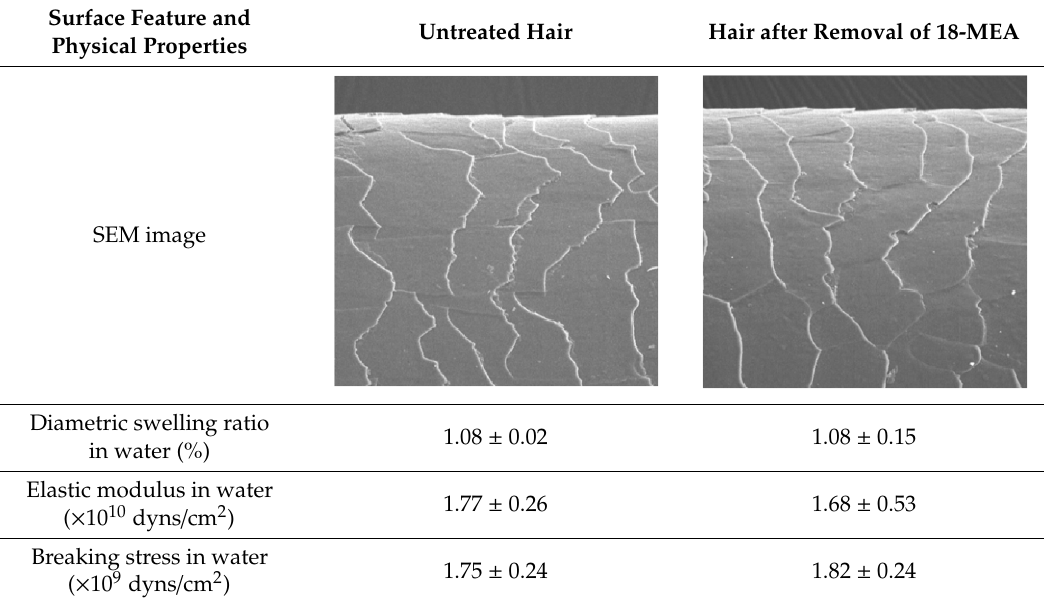
Table 5. Structural and physical properties of hair before and after removing 18-MEA (N = 7). Surface Feature and